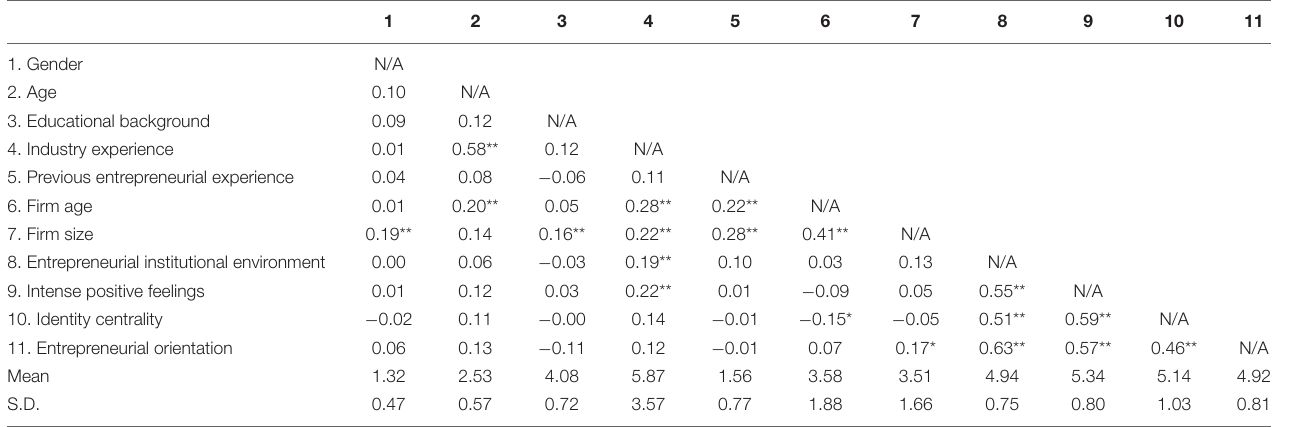
TABLE 4 | Descriptive statistical analysis.